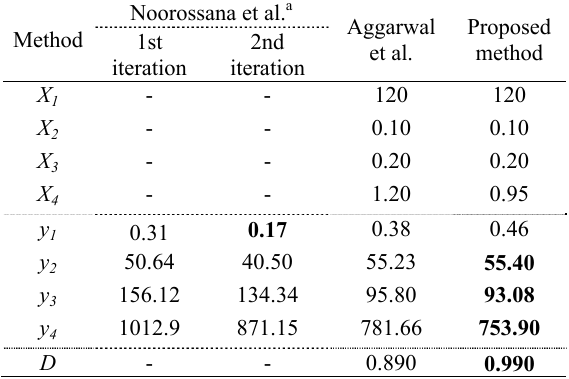
Table 21. Comparison of results for example 6: Methods from literature and approach proposed